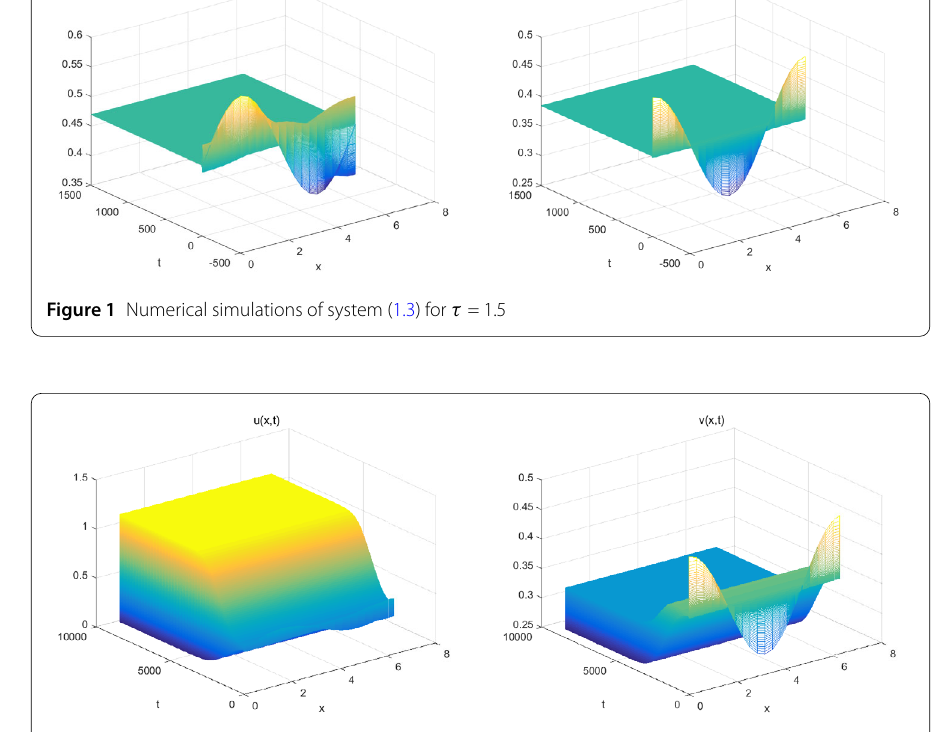
Figure 2 Numerical simulations of system (1.3) for τ =